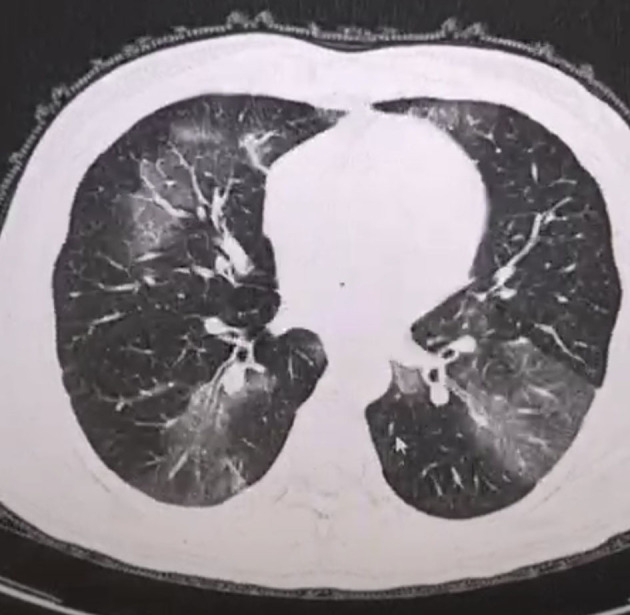
Multiple external subpleural ground-glass opacity.